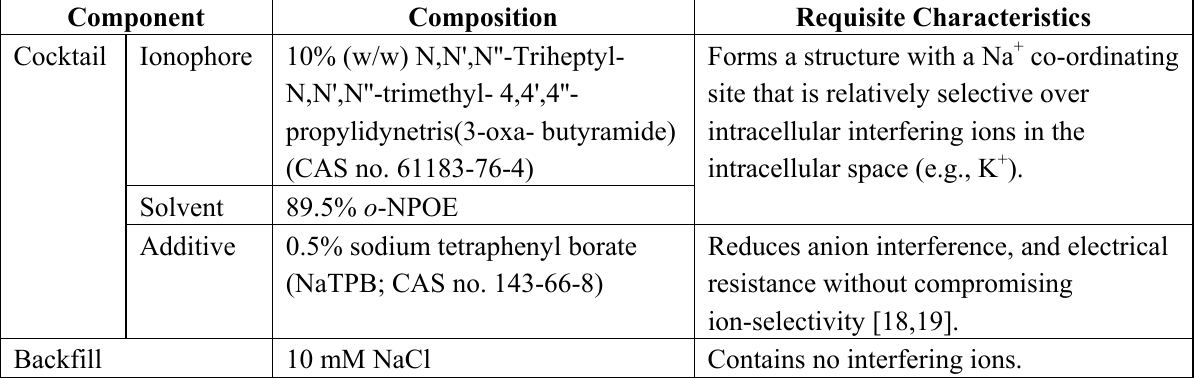
Table 2. The composition and components of Na + -selective ionophore I cocktail A (cat. no. 99314, Sigma) and associated backfill solution. Further details are provided at The Sensor Application Portal hosted at www.sigmaaldrich.com.